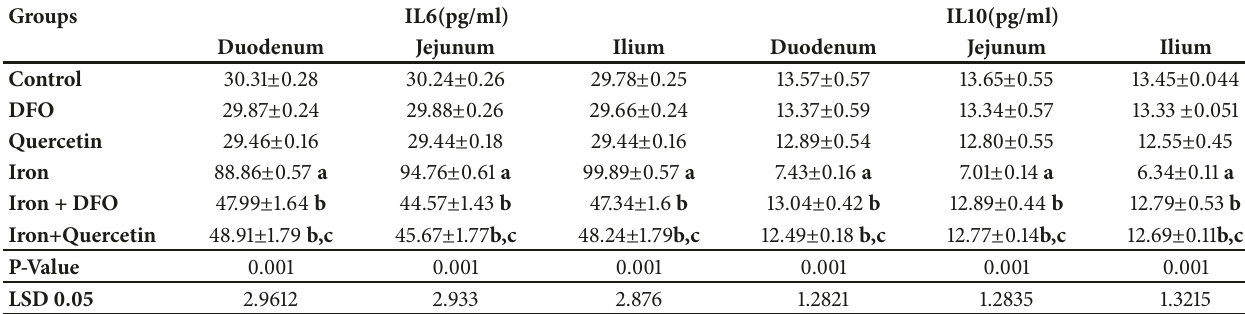
Table 4: Effects of Quercetin in comparison to DFO on IL6 and IL10 of small intestinal tissues in iron overloaded rats.